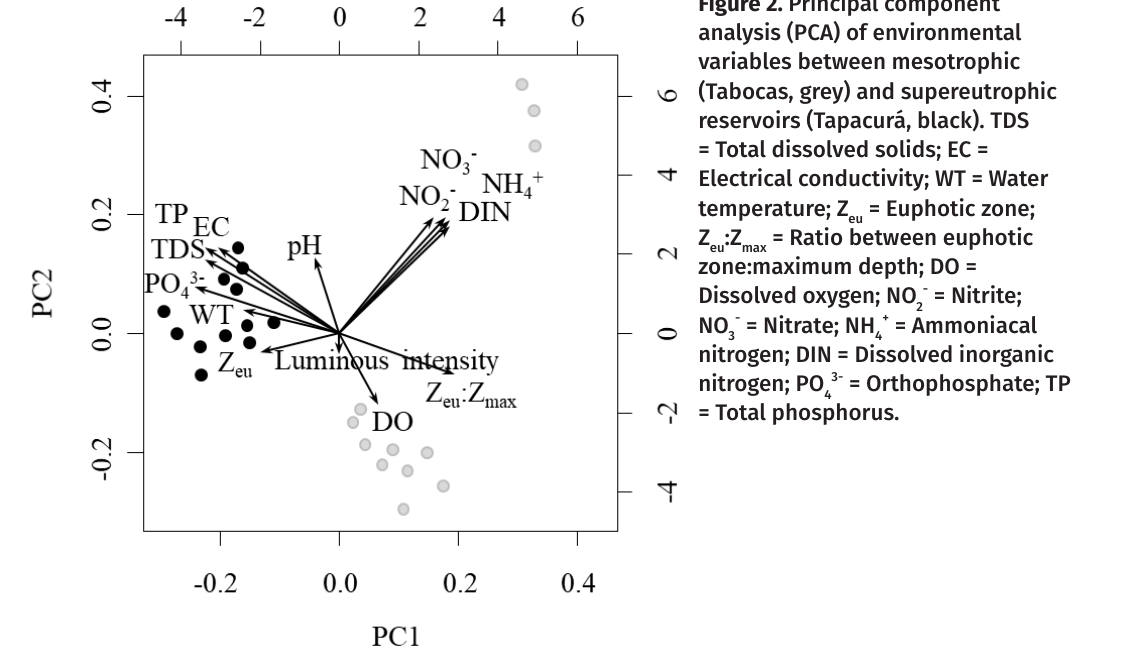
Figure 2. Principal component analysis (PCA) of environmental variables between mesotrophic (Tabocas, grey) and supereutrophic reservoirs (Tapacurá, black).